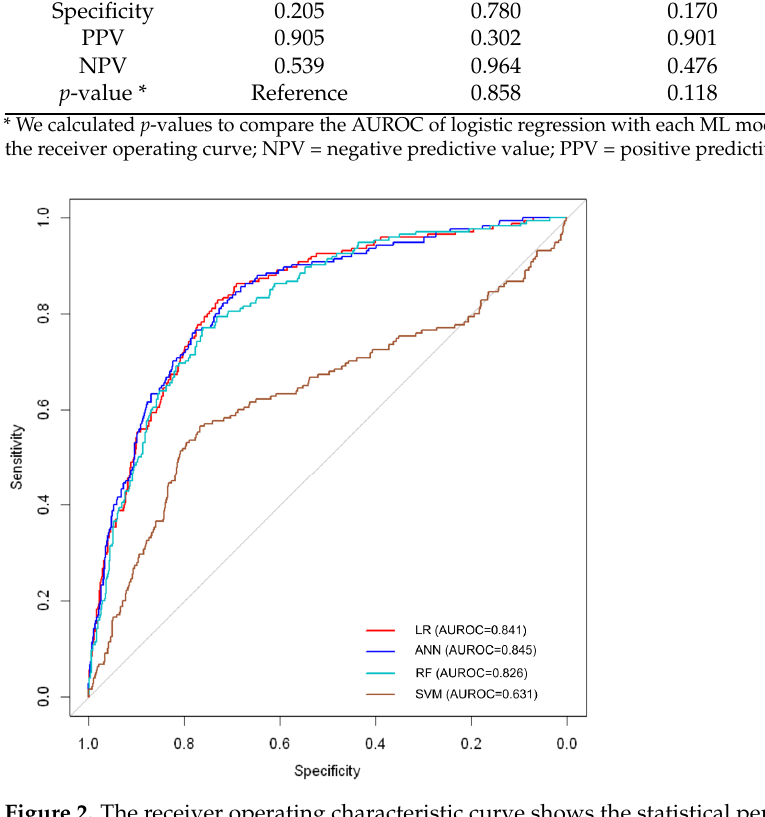
Figure 2. The receiver operating characteristic curve shows the statistical performance of mortality prediction by the LR, ANN, RF, and SVM models in very low birth weight infants. LR = logistic regression; ANN = artificial neural network; RF = random forest; SVM = support vector machine.